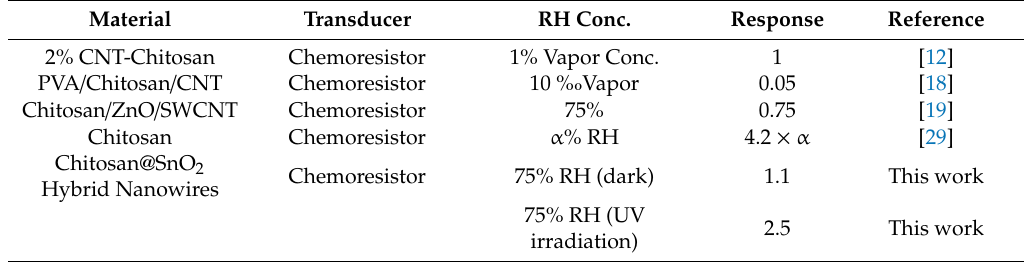
Table 1. Comparison table of chitosan-based conductometric humidity